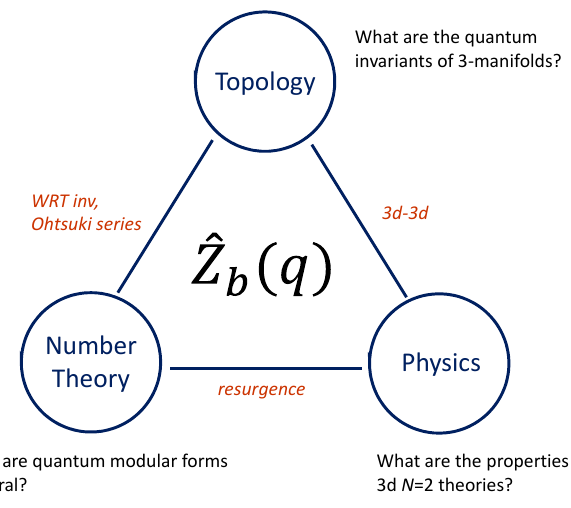
Figure 1 . The di(cid:11)erent topics involved in this